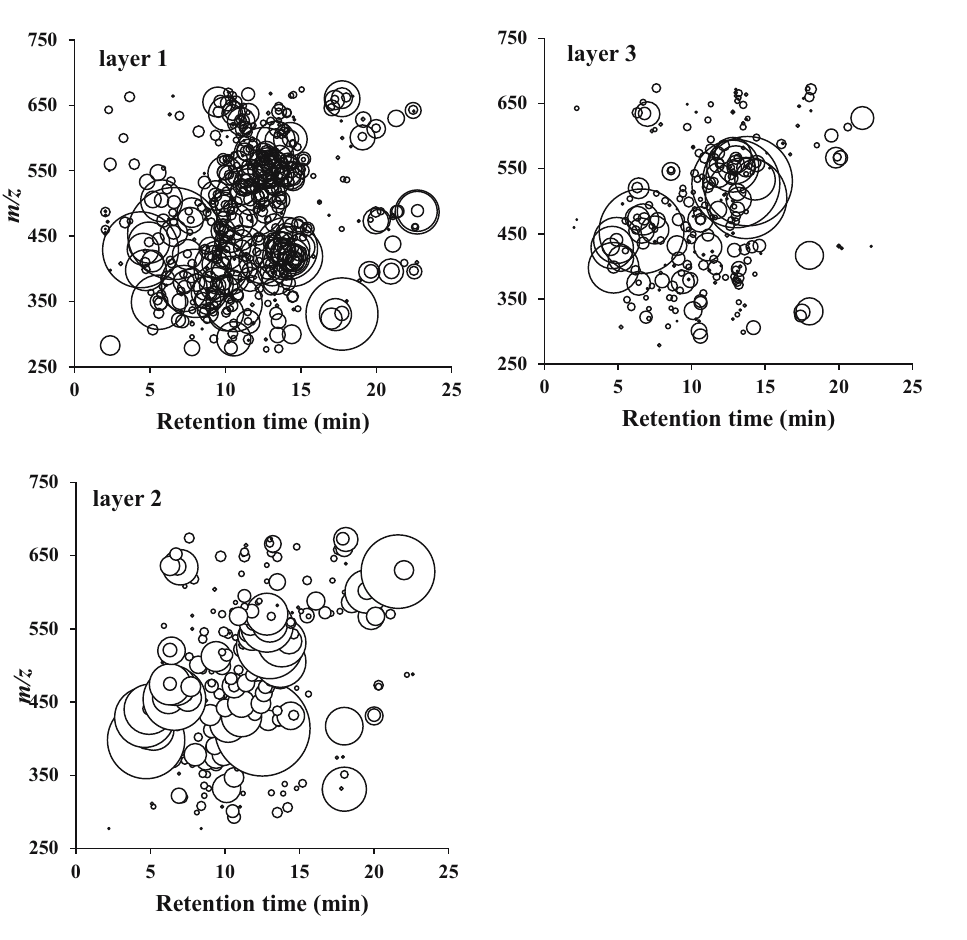
Figure 1: The CC distribution in cabbage